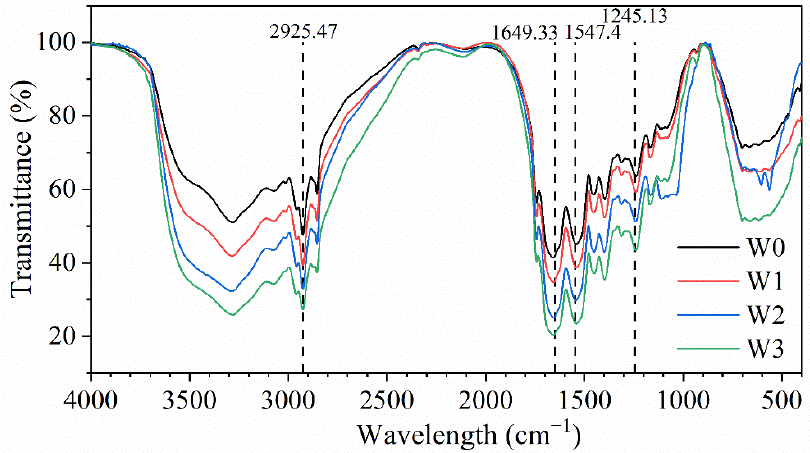
Figure 1. The FTIR spectra of surimi gel with different washing times.